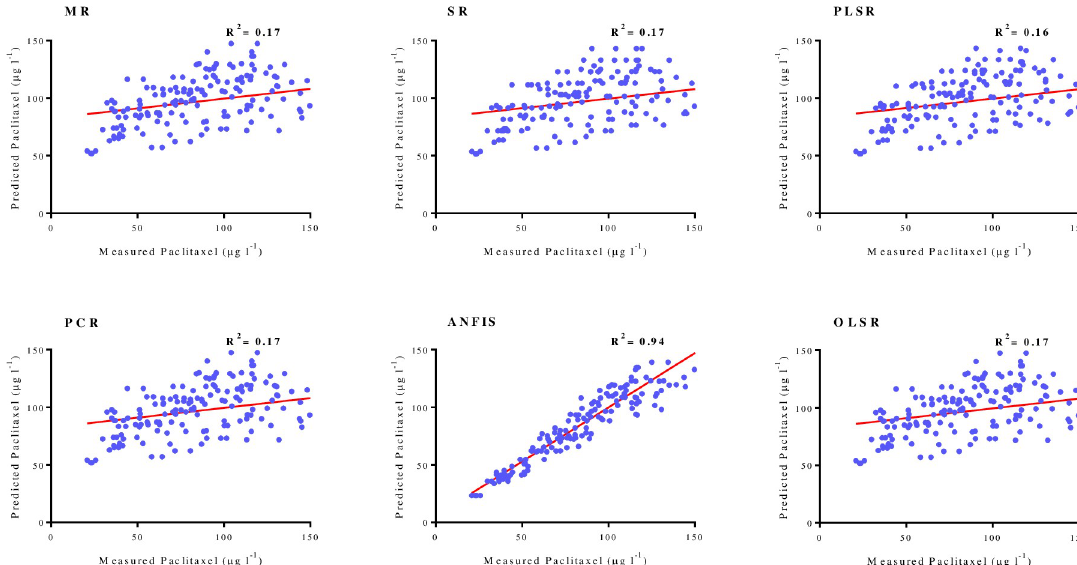
Fig 4. Scatter plot of actual data against predicted values of paclitaxel biosynthesis in Corylus avellana cell cultures exposed with different concentration of fungal cell extract (CE), either individually or combined treatment with 50 mM methyl- β -cyclodextrin (MBCD), using adaptive neuro-fuzzy inference system (ANFIS), multiple liner regression (MLR) stepwise regression (SR), ordinary least squares regression (OLSR), principal component regression (PCR) and partial least squares regression (PLSR) models in training subset. The solid line shows fitted simple regression line on scatter points.